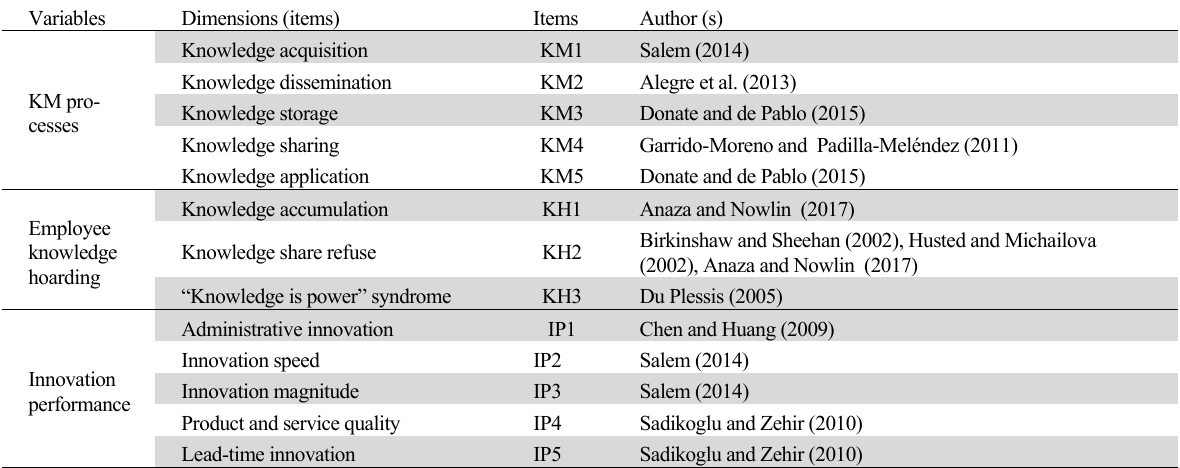
Measurements used to assess variables in the current